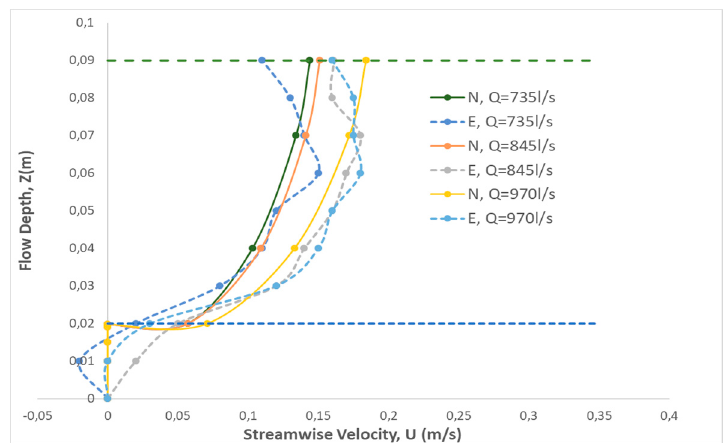
Figure 3. Velocity profiles for h = 9 cm, (N) for numerical results, (E) for experimental results.